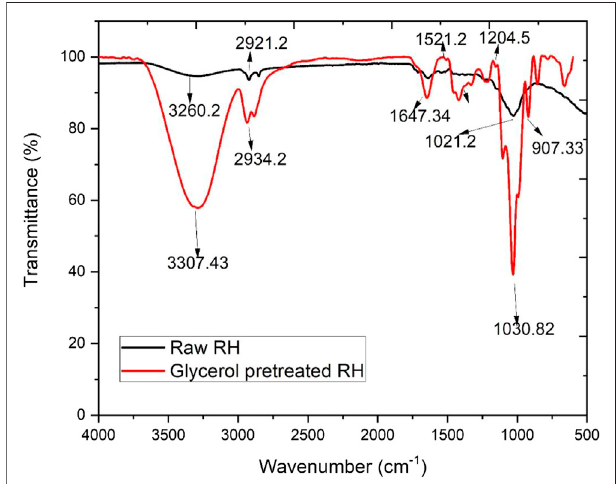
FIGURE 2 | TIR spectra with and without glycerol pretreatment of